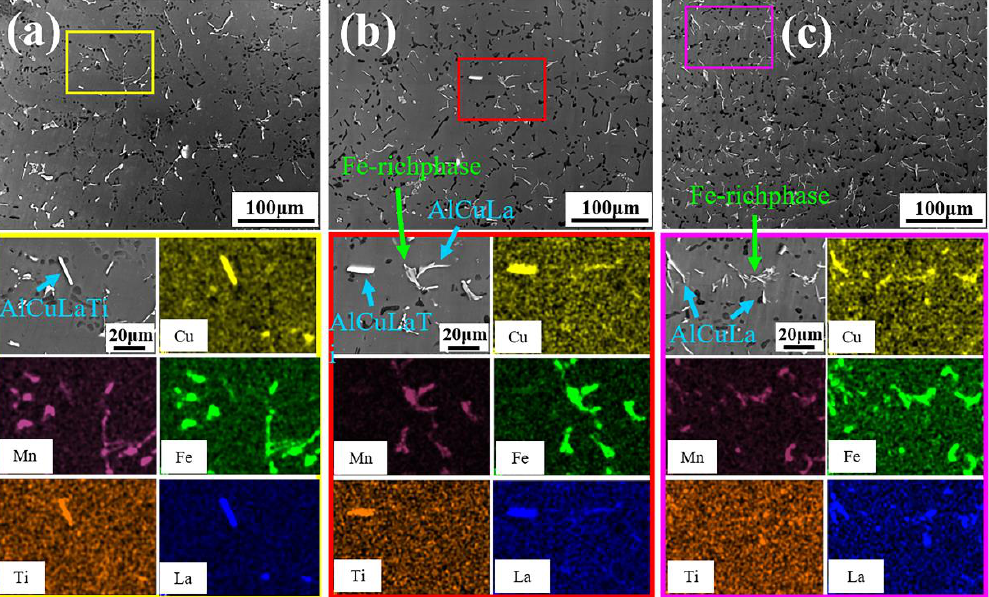
Figure 8. SEM/EDS microstructure images of 3 groups of alloys after peak aging: ( a )AlTiB + 0.05La; ( b ) AlTiB + 0.1La; ( c ) AlTiB + 0.3La.